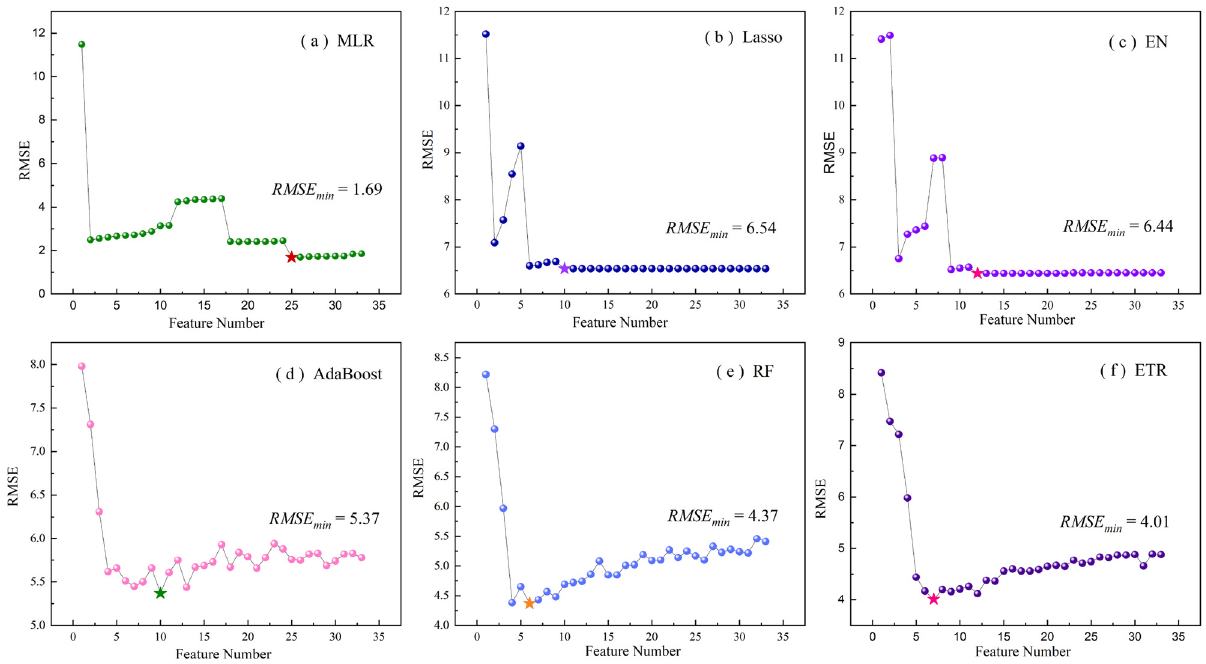
Figure 3: The procedures of feature selection in RFE based on the base_estimators: ( a ) MLR, ( b ) Lasso, ( c ) EN, ( d ) AdaBoost, ( e ) RF, and ( f ) ETR.